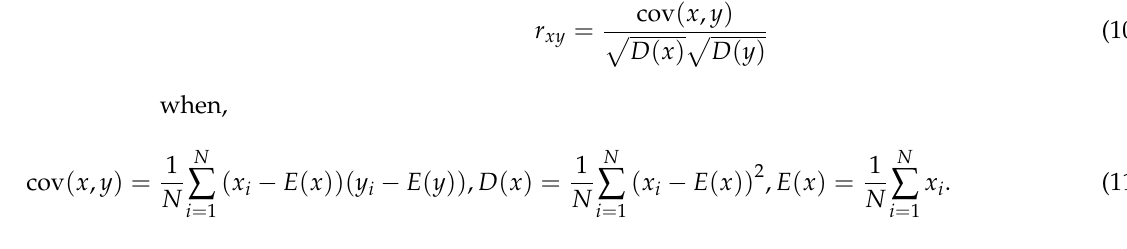
Figure 9. RGB histogram of Lena after encryption. ( a ) encrypted, Lena’s R ‐ channel pixel histo ‐ gram; ( b ) encrypted, G ‐ channel pixel histogram; ( c ) encrypted, B ‐ channel pixel histogram.